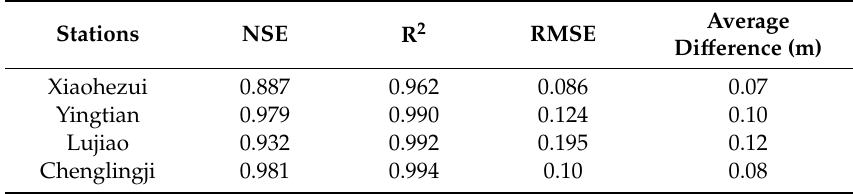
Table 1. The Nash–Sutcliffe efficiency coefficients (NSE), R 2 and the root mean square error (RMSE) calculated at the main hydrological stations in Dongting Lake.